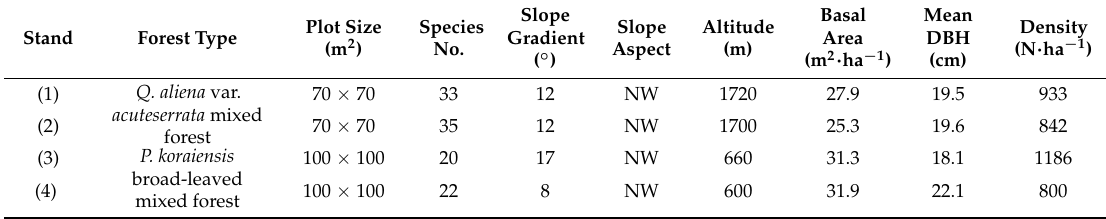
Table 1. Overview of survey sample plot details.